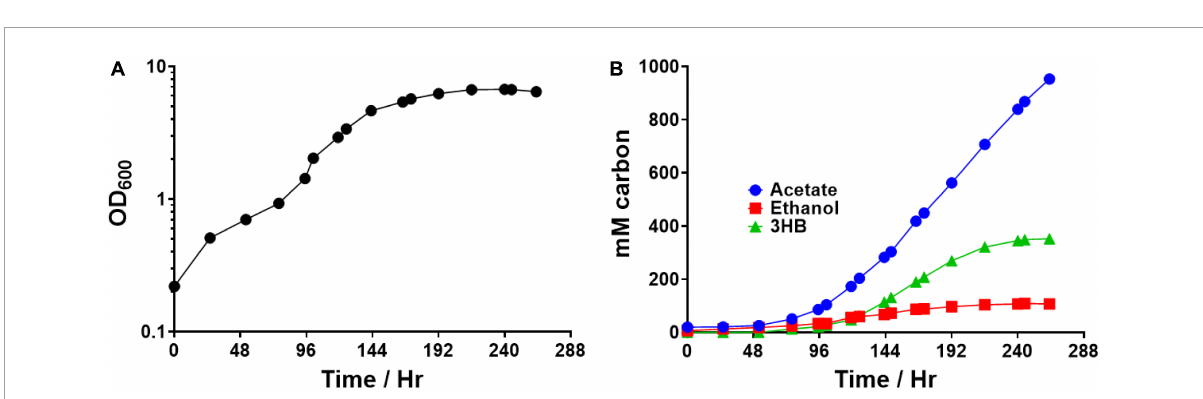
FIGURE7 Autotrophic bioreactor fermentation product profile of Clostridium ljungdahlii integrated 3HB strain expressing additional thl and hbd2 . The strain contains the atoB thiolase from Escherichia coli and CoA transferase from C. acetobutylicum integrated into the genome with an additional thl2 and hbd2 overexpressed on a replicating plasmid. (A) Optical density over time (B) Fermentation product profile over time in mM